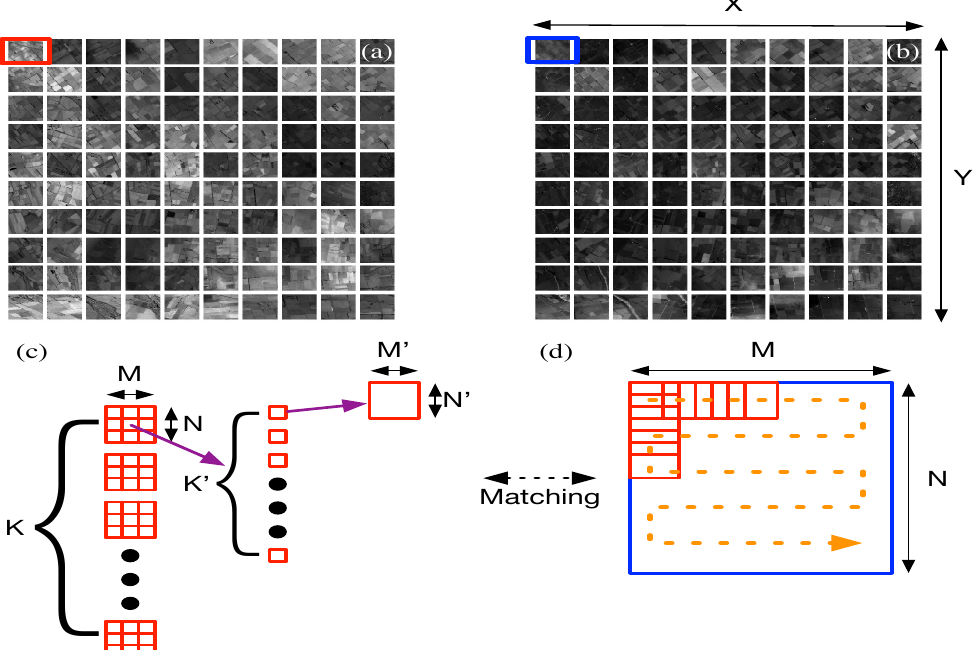
Figure 6. Graphical representation of Algorithm 2: ( a ) reference image; ( b ) sensed image; ( c ) template image; and ( d ) target